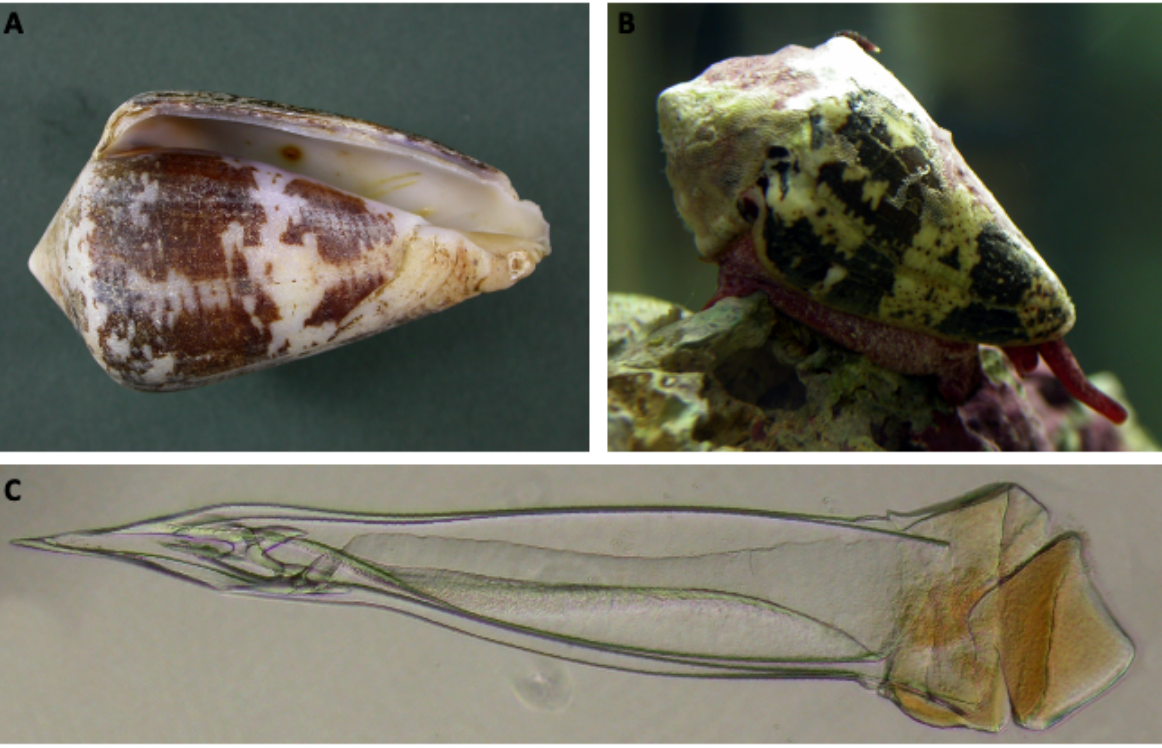
Figure 1. Examples of cone snail species found off the Brazilian coast. (A) Conus ermineus shell . MNRJ 8741. 70.2 x 40.4 mm. (B) Conus regius live specimen. Rio de Janeiro National Museum collection (MNRJ) 9704. 47 mm. Photos by Paulo Márcio Costa. (C) Conus regius radula tooth. MNRJ 9608. Optical microscopy photo (200x) by Renata